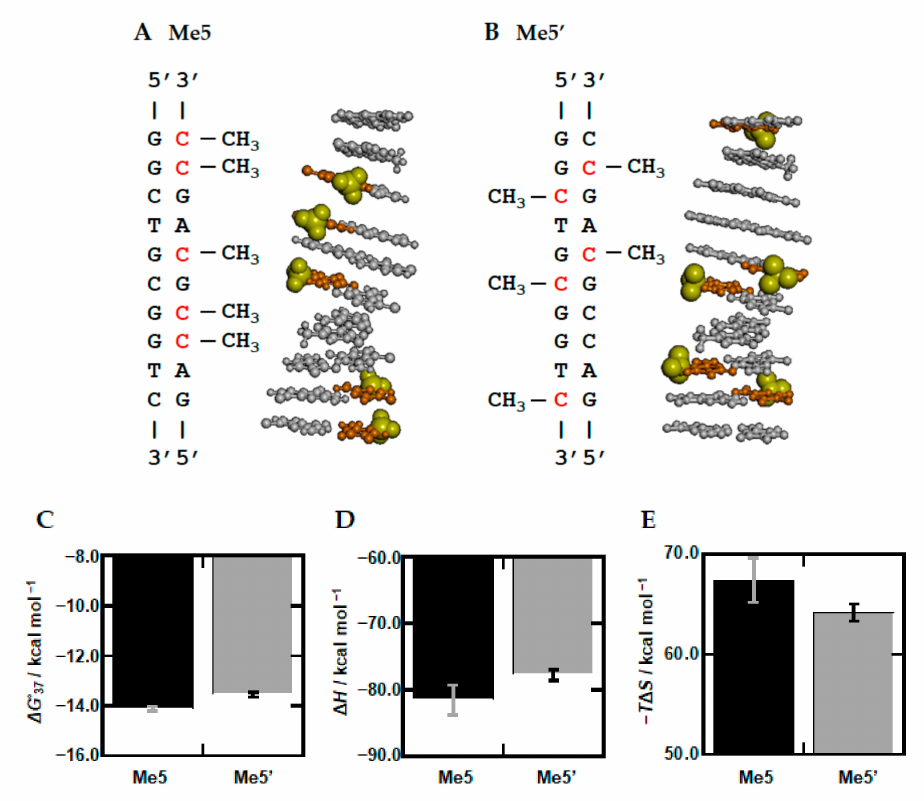
Figure 6. Sequences and schematic base position of Me5 and Me5 (cid:48) , and their thermodynamic parameters. Sequences and schematic base position of Me5 ( A ) and Me5 (cid:48) ( B ). The backbone is omitted for clarify. Methylated cytosine bases and methyl groups are shown in red and as yellow VDW models, respectively. The values of ∆ G ◦ 3 7 ( C ), ∆ H ◦ ( D ), and − T ∆ S ◦ ( E ) are shown for Me5 (black) and Me5 (cid:48) (gray) in 100 mM KCl